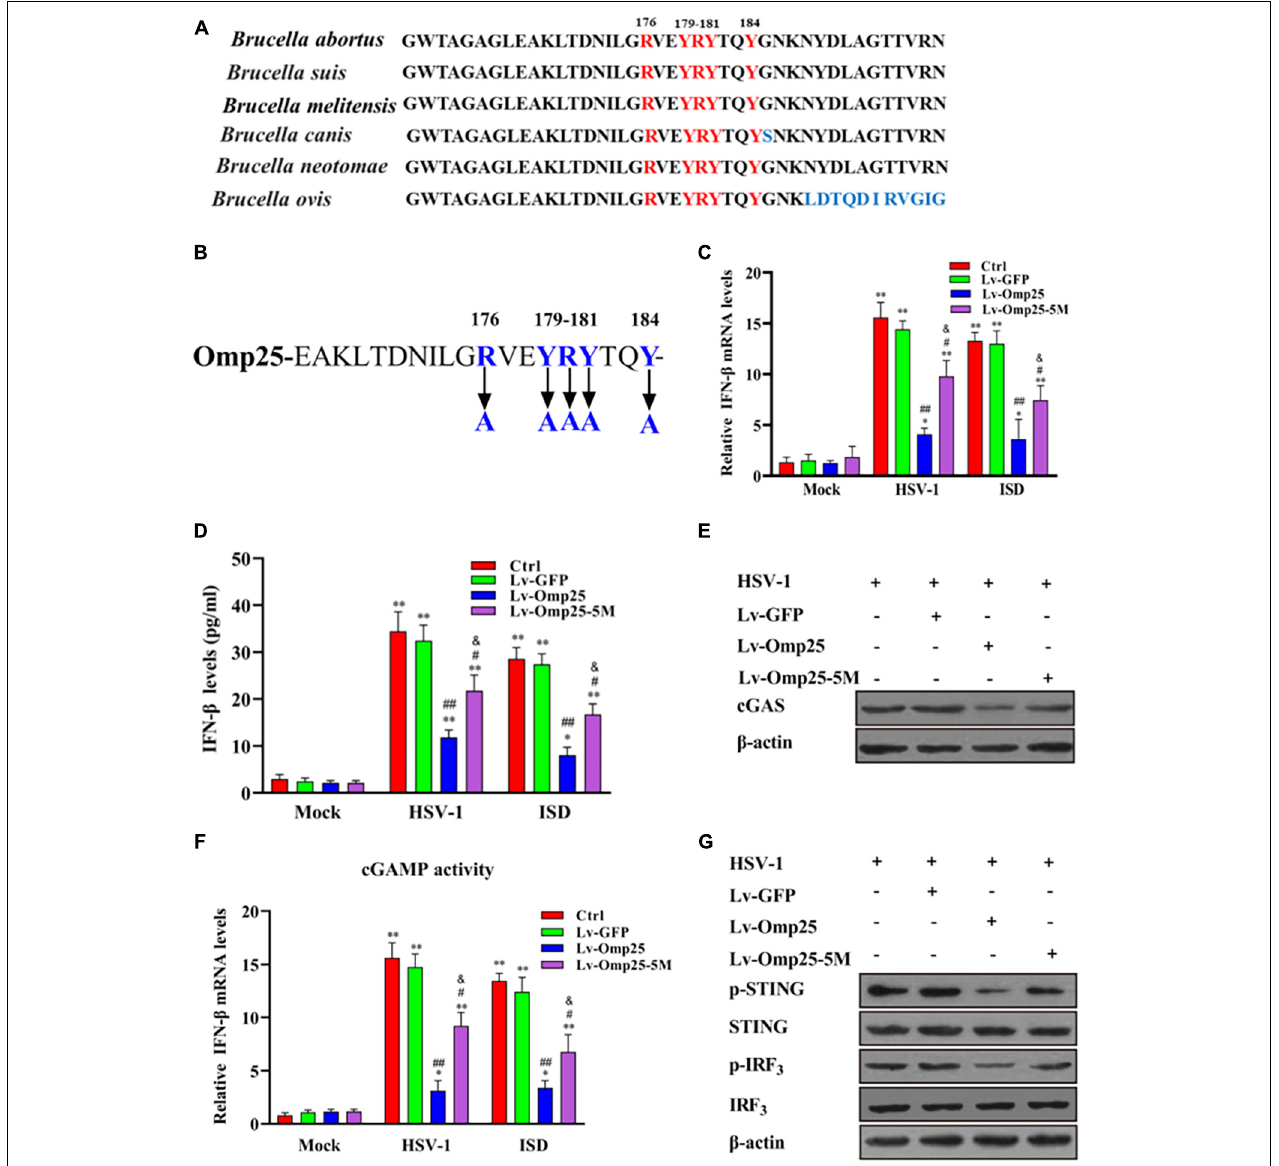
FIGURE 8 | Determination of key amino acid residue in Omp25 plays a critical role in Omp25 inhibition of IFN- β expression. (A) Alignment of Omp25 high conserved amino acid motif in different Brucella species. (B) Schematic diagram of Omp25 mutation in R176, Y179, R180, Y181, and Y184. (C–G) RAW264.7 cells were infected with Lv-Omp25, Lv-Omp25-5M, or Lv-GFP for 48 h, then infected with HSV-1 (10 MOI) or transfected with ISD (2 µ g/ml) for another 6 or 24 h. Cells were harvested and subjected to qRT-PCR analysis or ELISA analysis to examine expression of IFN- β (C,D) ; Western blotting was performed to detect levels of cGAS (E) ; qRT-PCR was used to detect levels of cGAMP in cell extracts as described in section “Materials and Methods” (F) , and phosphorylation levels of STING and IRF3 were measured by Western blotting (G) . * P < 0.05, ** P < 0.01 versus mock group, # P < 0.05, ## P < 0.01 versus Lv-GFP-infected cells in same groups. & P < 0.05 versus Lv-Omp25 infected cells in same